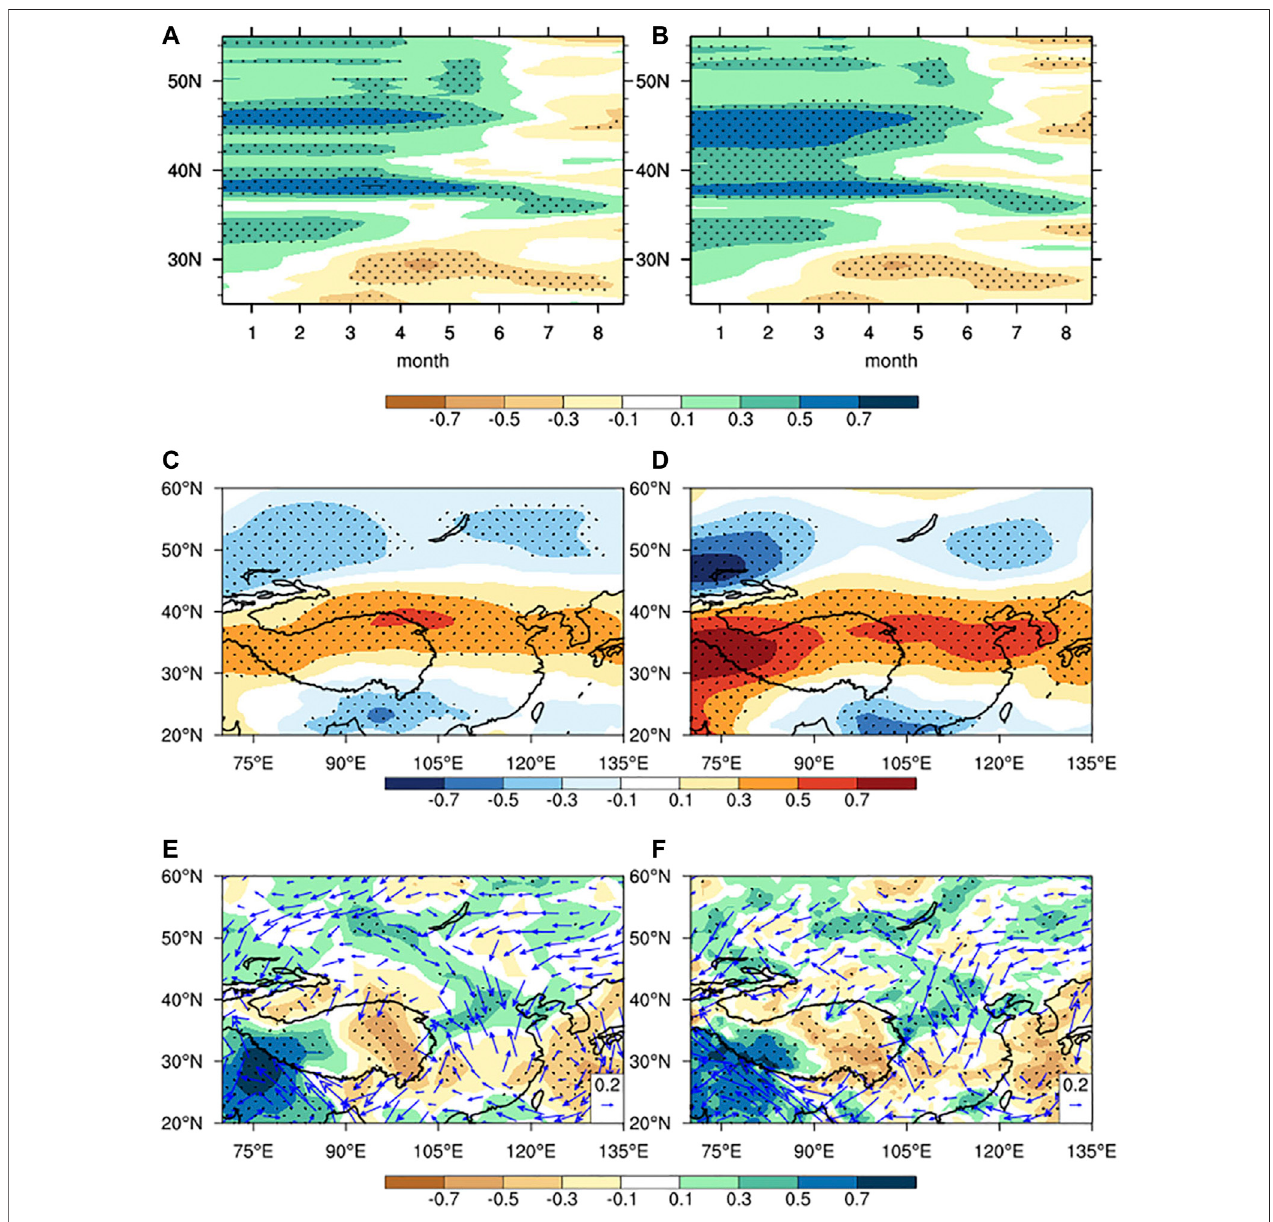
FIGURE6|(A,C,E) Correlationcoef fi cientsbetweenthePC1ofwinterNHsnowcoverand (A) soilmoisturewithtimealong115 – 120 ° E, (C) summer200 hPazonal wind, and (E) summer total precipitation (shade); 850 hPa wind (vectors). (B,D,F) As in (A,C,E) but for the PC1 of summer CHDEs. Black dots in (A-F) indicate values signi fi cant at the 95% con fi dence level. A positive correlation for zonal or meridional wind component is denoted by an eastward or poleward arrow, respectively.